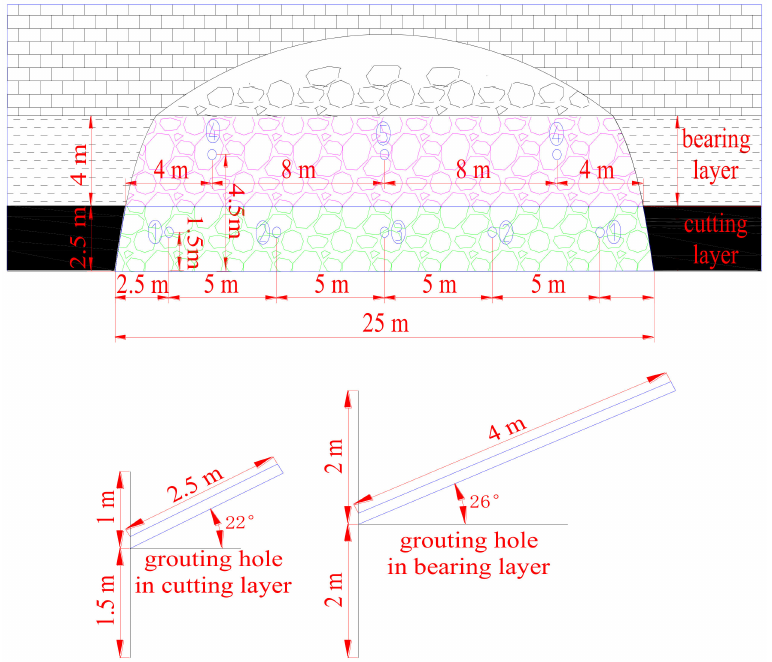
Figure 12. Layered progressive grouting